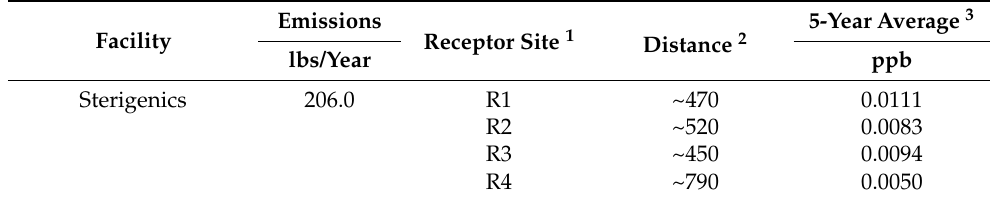
Table 5. Modeled residential ambient air EO concentrations for the three sterilization facilities in Georgia with corresponding with ambient EO monitoring